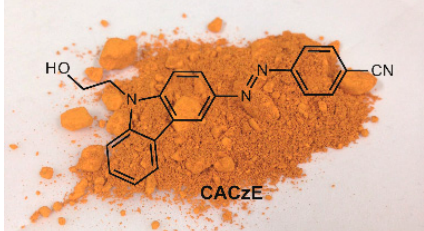
Figure 1. Structural formula of CACzE and background photograph of CACzE powder.